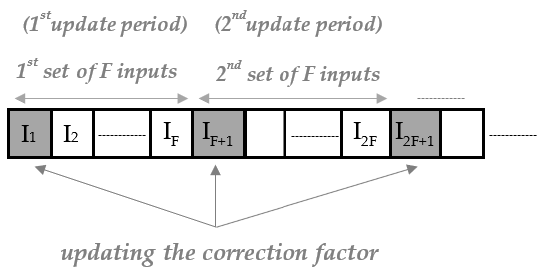
Figure 2. The proposed correction factor updating strategy.